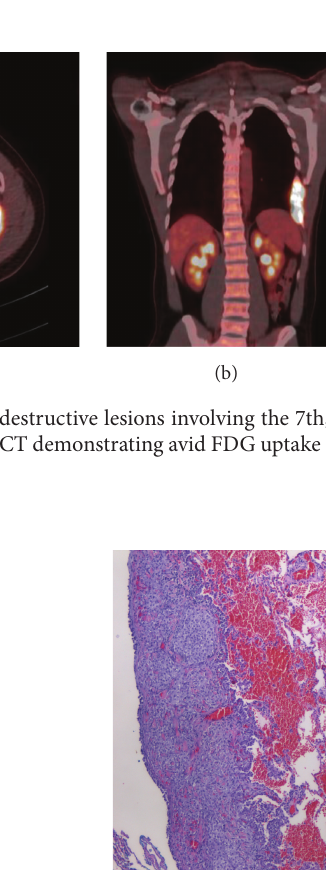
Figure 7: Resection specimen and chest wall tumor: D2-40 IHC- positive foci, sarcomatoid component.